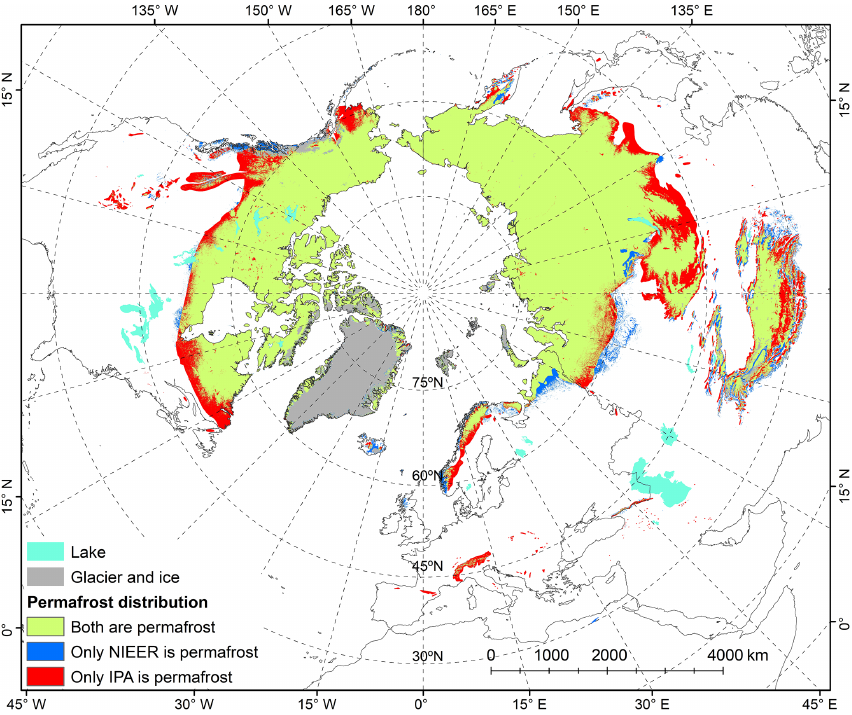
Figure 7. The spatial difference of the permafrost region proposed in this study (defined as the regions where the probability of permafrost occurrence is greater than 0) with the circum-Arctic permafrost map from International Permafrost Association (Brown et al., 2002).